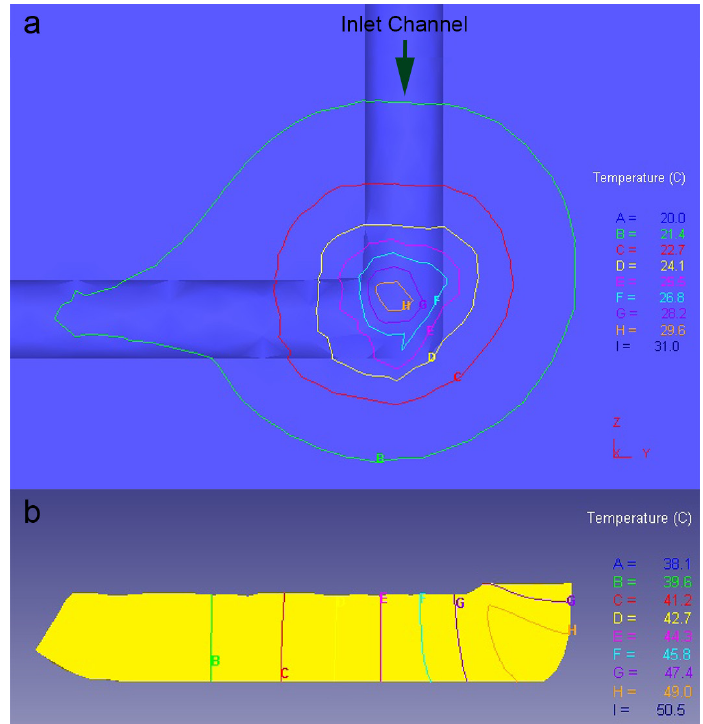
Fig.2: Temperature contours on (a) die, (b) billet when punch